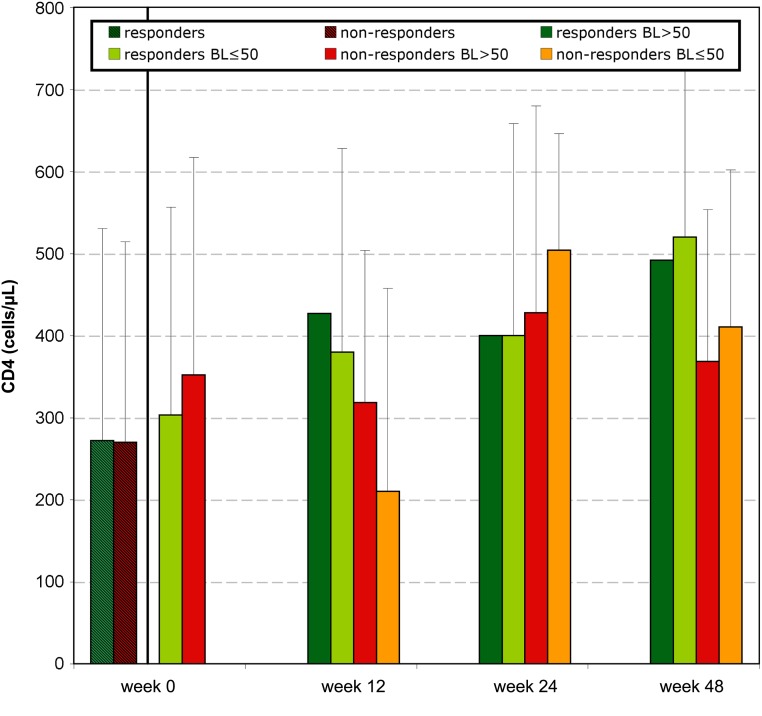
CD4 follow-up of the 108 patients.Depicted data correspond to CD4 mean values with standard deviations. Week 0: data from 97 patients who subsequently responded to treatment (responders) are represented in striped green; data from 11 patients that subsequently did not respond to treatment at any time (non-responders) are represented in striped red. Week 0, 12, 24, 48: responding patients: data from patients responding to the therapy at the corresponding sampling date are displayed in green: those who started MVC therapy with undetectable VL in light green, and those with baseline (BL) VL above detection limit in dark green; non-responding patients: data from patients not responding to the therapy at the corresponding sampling date are displayed in red (those with detectable baseline VL) and in orange (those with undetectable baseline VL).